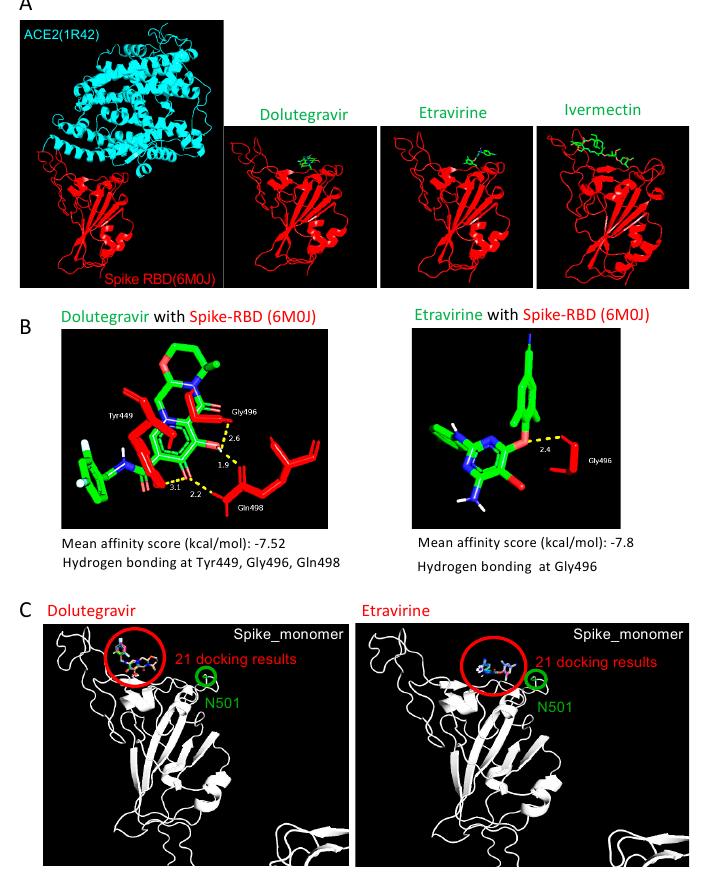
Figure 5. Structural simulation of Spike-RBD with drug candidates. ( A ) Visualization of the interaction pattern of ACE2-spike RBD (PDB ID: 6M0J). Dolutegravir and Etravirine structure were obtained from Pubchem; Ivermectin structure was obtained from ChemSpider. Potential interactions between entry inhibitors and ACE2 (PDB ID: 1R42) or spike RBD (PDB ID: 6M0J) were predicted by AutoDock Vina five times, and the mean affinity was further calculated. Interaction hydrogen bonds and residues were labeled by Pymol. ( B ) The predicted interaction of Dolutegravir ( left ) and Etravirine ( right ) with wild-type spike RBD. ( C ) Visualization of the 21 docking results of entry inhibitors (red circle) on the spike N501Y mutant (green circle). The N501Y residue located outside the binding interphases between Etravirine-RBD and